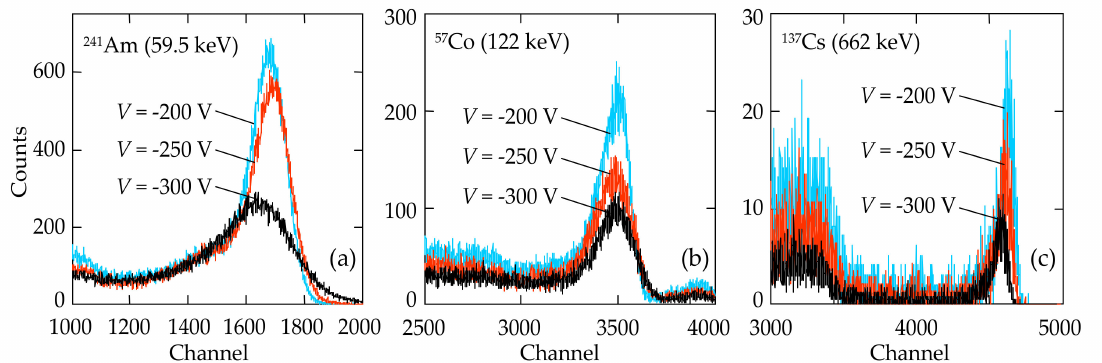
Figure 12. Room temperature spectra of ( a ) 241 Am (59.5 keV), ( b ) 57 Co (122 keV), and ( c ) 137 Cs (662 keV) isotopes at different bias voltages ( − 200 V, − 250 V, and − 300 V) taken with the In/CdTe/Au p-n junction detector, fabricated by laser radiation of the In